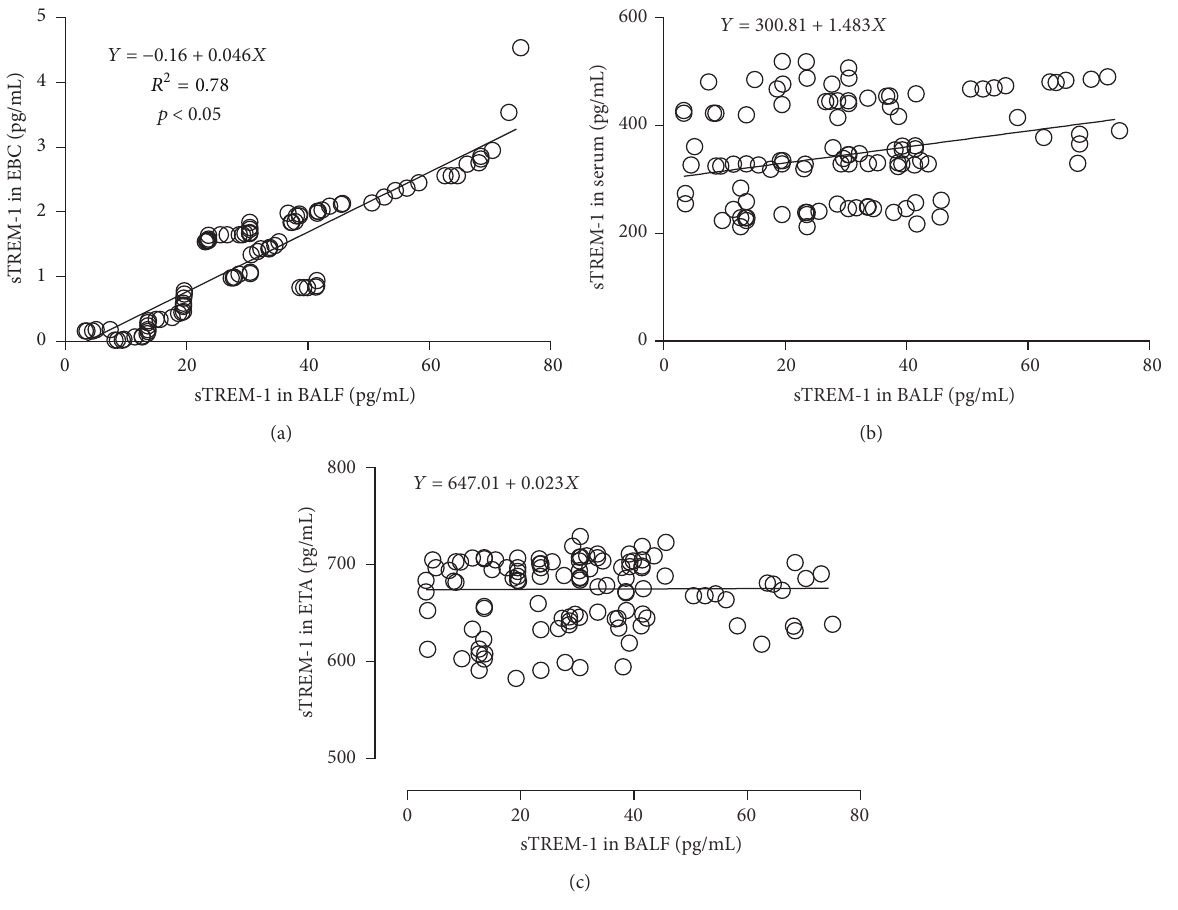
Figure 3: Correlation of sTREM-1 in different samples. (a) Correlation of BALF and EBC sTREM-1 concentration. (b) Correlation of BALF and serum sTREM-1 concentration. (c) Correlation of BALF and ETA sTREM-1